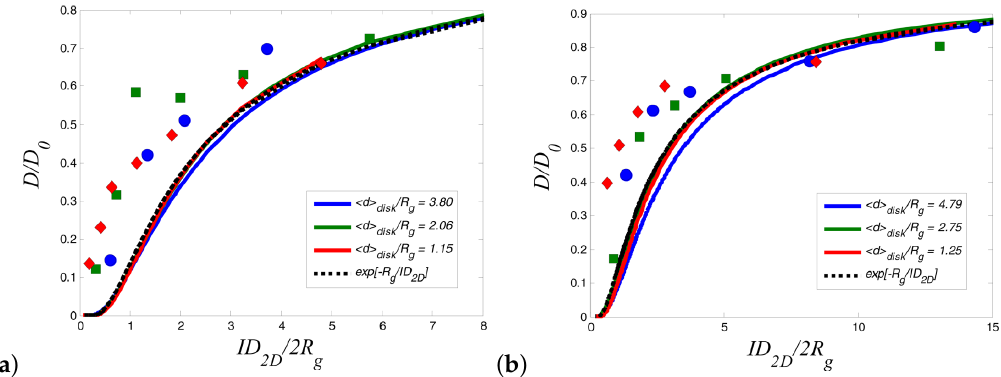
Figure 17. ( a ) Plot of reduced diffusion coefficient [215] versus the confinement parameter for the poly(styrene) data from Martin et al. [216]. ( b ) Reduced diffusion coefficient versus 2D confinement parameter ID 2D /2 R g for the deuterated PMMA/PMMA couple from Lin et al. [217]. Reproduced from [215] with permission from